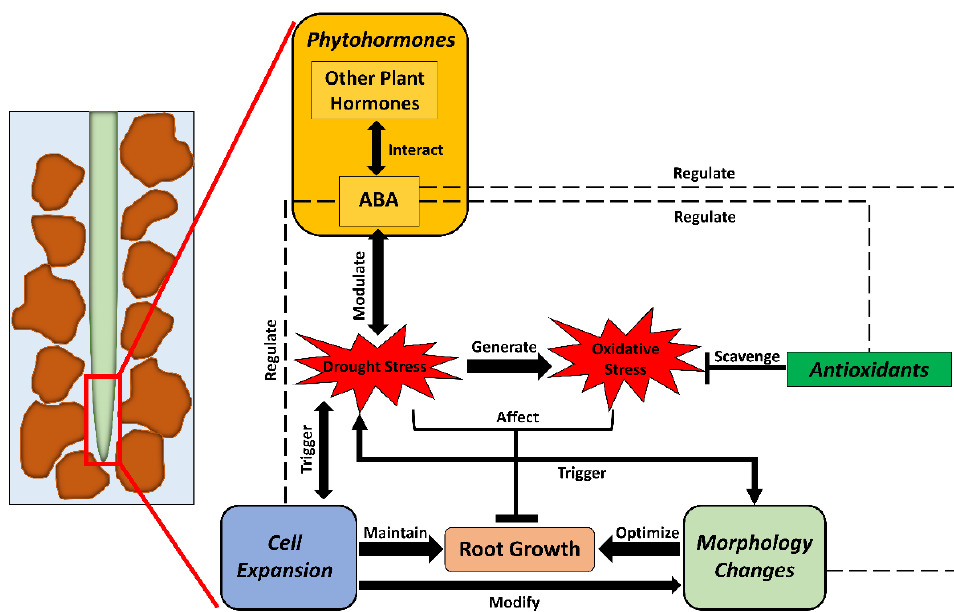
Figure 5. Overview of physiological and metabolic processes for growth maintenance of crop roots under drought stress. When exposed to drought, plant roots start to modify osmotic regulation to maintain turgor for continued root growth. Simultaneously, root morphological traits are changed to adapt to the lowering water status. Meanwhile, oxidative stress is generated in root tissue when cellular homeostasis becomes unbalanced. Under this circumstance, crop roots activate the antioxidative system rebalance cellular homeostasis. Plant hormones also modulate osmotic regulation and antioxidative mechanisms under drought conditions.